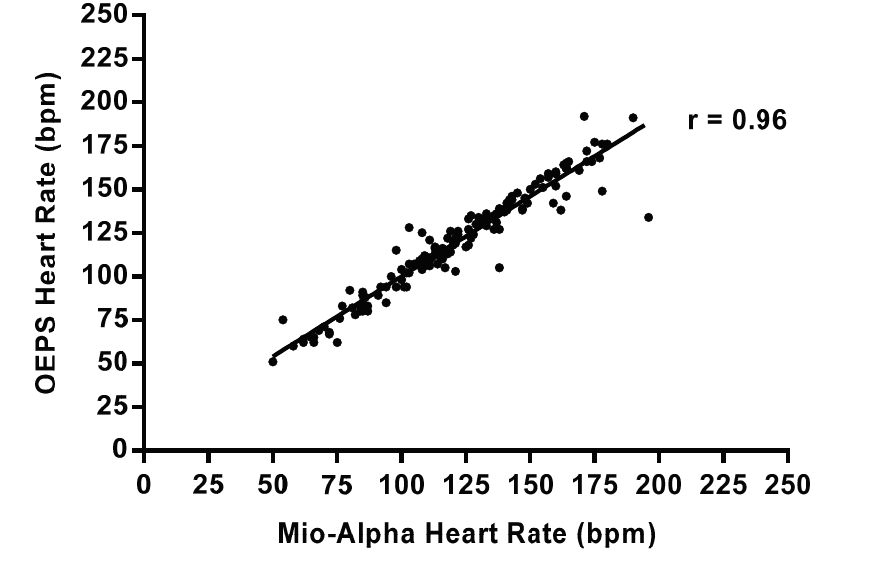
Figure 19. HR Correlation between Mio-Alpha and the OEPS (r = 0.96, p < 0.0001) during rest and differing exercise modalities and